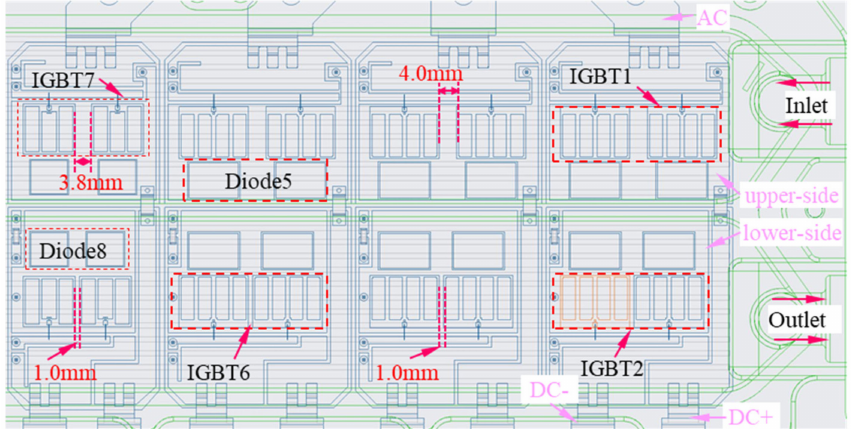
Figure 9. The placement design of parallel power dies in GM_1 and GM_2, where the green lines are the wireframes of strip-fin structures of the heat sink at the bottom.